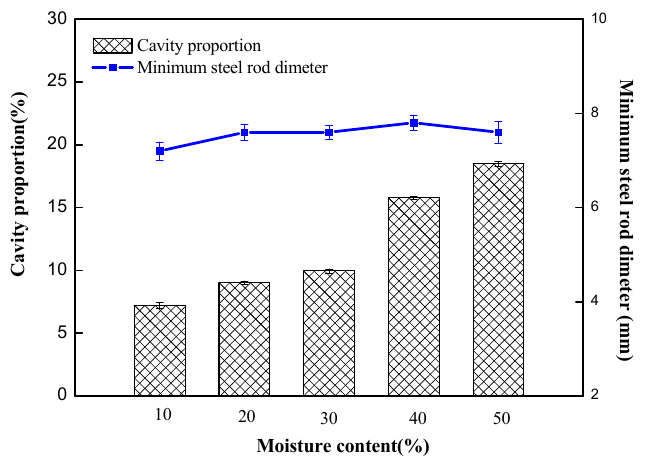
Figure 3. Effects of initial moisture content (MC) on the cavity proportion and flexibility of the PE film reinforced Fraxinus mandshurica veneer.